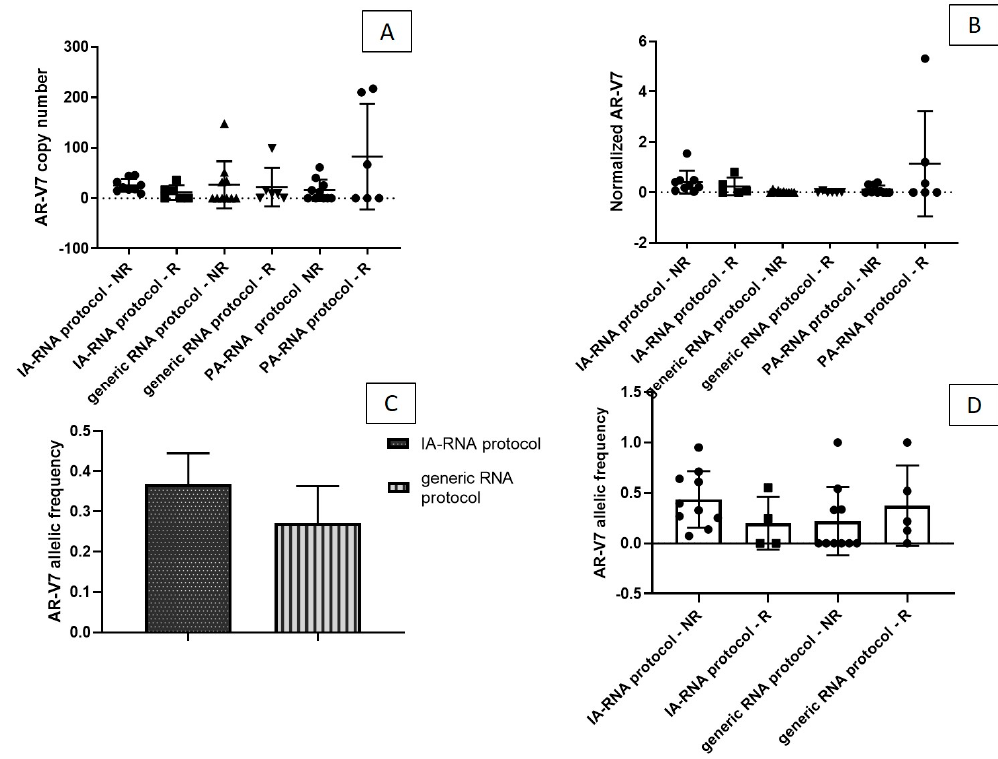
Figure 2. ( A ) AR -V7 and ( B ) normalized AR -V7 copies/mL, in responder (R) and non-responder